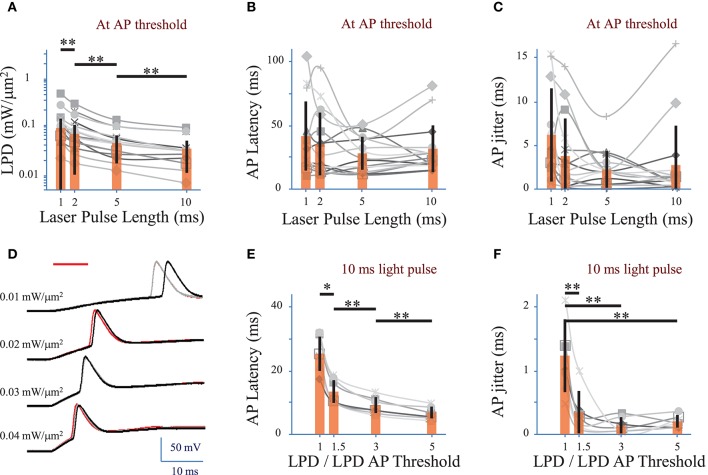
Optimization of parameters to evoke an action potential in neurons of mouse visual cortex Layer 2/3 with a fiber amplified Laser System at 1030 nm. (A) Laser power density (LPD) necessary to evoke an AP with 1 to 10 ms long 2P holographic spots (15 μm diameter, over the cell soma) (n = 16 cells, average of 3 repetitions for each). Individual cells (gray), average (orange bars) and s.d. (error bars). (**) (p = 0.01, Wilcoxon paired T-test). (B) Latency between the AP evoked by 1 to 10 ms long 2P holographic spots (15 μm diameter, over the cell soma) at the LPD for AP threshold and the onset of the 2P stimulation (n = 16 cells, average of 3 repetitions for each). Individual cells (gray), average (orange bars) and s.d. (error bars). The latency did not vary significantly with the pulse length at AP threshold. (C) Same as (B) with AP jitter. The jitter did not vary significantly with the pulse length at AP threshold. (D) Voltage response of a L2/3 pyramidal cell infected with AAV1 CamKII-ReaChR-p2A-YFP to a series of 10-ms long 2P holographic spots (15 μm diameter, over the cell soma) of constant Laser Power Density (LPD) (red bar). Steady state current injection was used to keep the cell voltage at −70 mV in resting conditions. Three repetitions for each LPD. (E) Latency between the AP evoked by 10 ms long 2P stimulation and the onset of 2P stimulation (n = 7 pyramidal cells, average of 3 repetitions for each), at LPDs varying from the LPD necessary to reach the AP threshold to 5 times this value. Example of recording on panel D. Individual cells (gray), average (orange bars) and s.d. (error bars). The latency significantly (*) (p = 0.05, Wilcoxon paired T-test) or very significantly (**) (p = 0.01, Wilcoxon paired T-test) decreased when the LPD was increased. (F) Same as (E) with AP jitter. The jitter very significantly decreased (**) (p = 0.01, Wilcoxon paired T-test) when LPD was increased in comparison to the jitter at LPD used to reach the AP threshold.